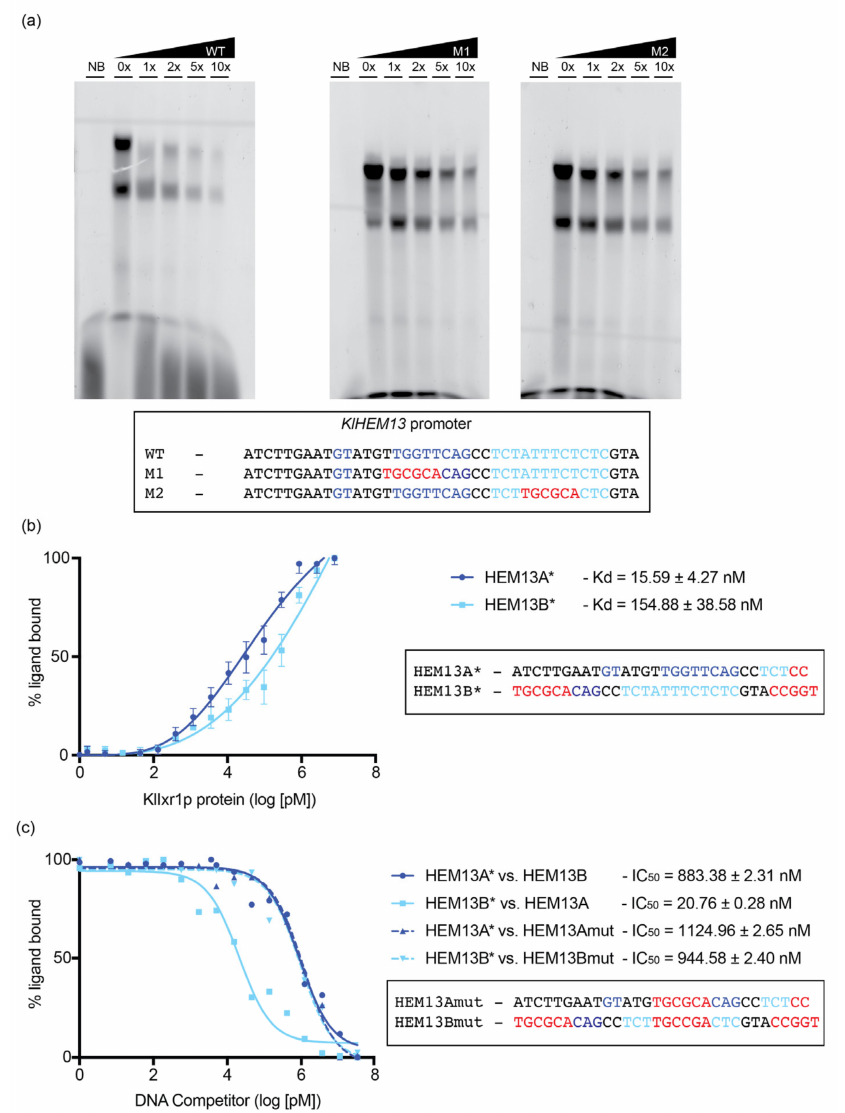
Figure 5. Analysis of Kl Ixr1 protein binding to the KlHEM13 promoter region. ( a ) EMSA assays show- ing sequence specificity to both binding sites found using the consensus sequences YYYATTGTTCTC and KTTSAAYKGTTYASA previously described [23,24]. Competition assays were conducted with increasing amounts of non-labeled ligands indicated. WT: ligand not mutated; M1: ligand mutated in first site; M2: ligand mutated in second site; NB: no retarded band (no protein added). ( b ) Klotz plots representing quantitative analysis of Kl Ixr1 binding to both KlHEM13 promoter deduced sites. DNA binding measured by fluorescence anisotropy changes of the 5 (cid:48) fluorescein-labelled DNA (100 nM ligand) upon protein titration (see Section 2). The resulting semi-log binding isotherms were fitted to a 1:1 binding model with non-linear least squares regression. Data points are the average of 3 independent experiments, error bars representing standard deviations. HEM13A: first binding site deduced from KTTSAAYKGTTYASA [23] consensus sequence; HEM13B: second binding site deduced from YYYATTGTTCTC [24] consensus sequence; * indicates FAM labeled ligand. ( c ) Klotz plots representing competition analysis of Kl Ixr1 binding to both KlHEM13 promoter-assayed sites. DNA binding measured by fluorescence anisotropy changes of the 5 (cid:48) fluorescein-labelled DNA (100 nM ligand) bound to Kl Ixr1 protein (200 nM) and upon non-labeled DNA competitor titration (see Section 2). The resulting semi-log binding isotherms were fitted to a logIC50 competitive model with non-linear least squares regression. * indicates FAM labeled